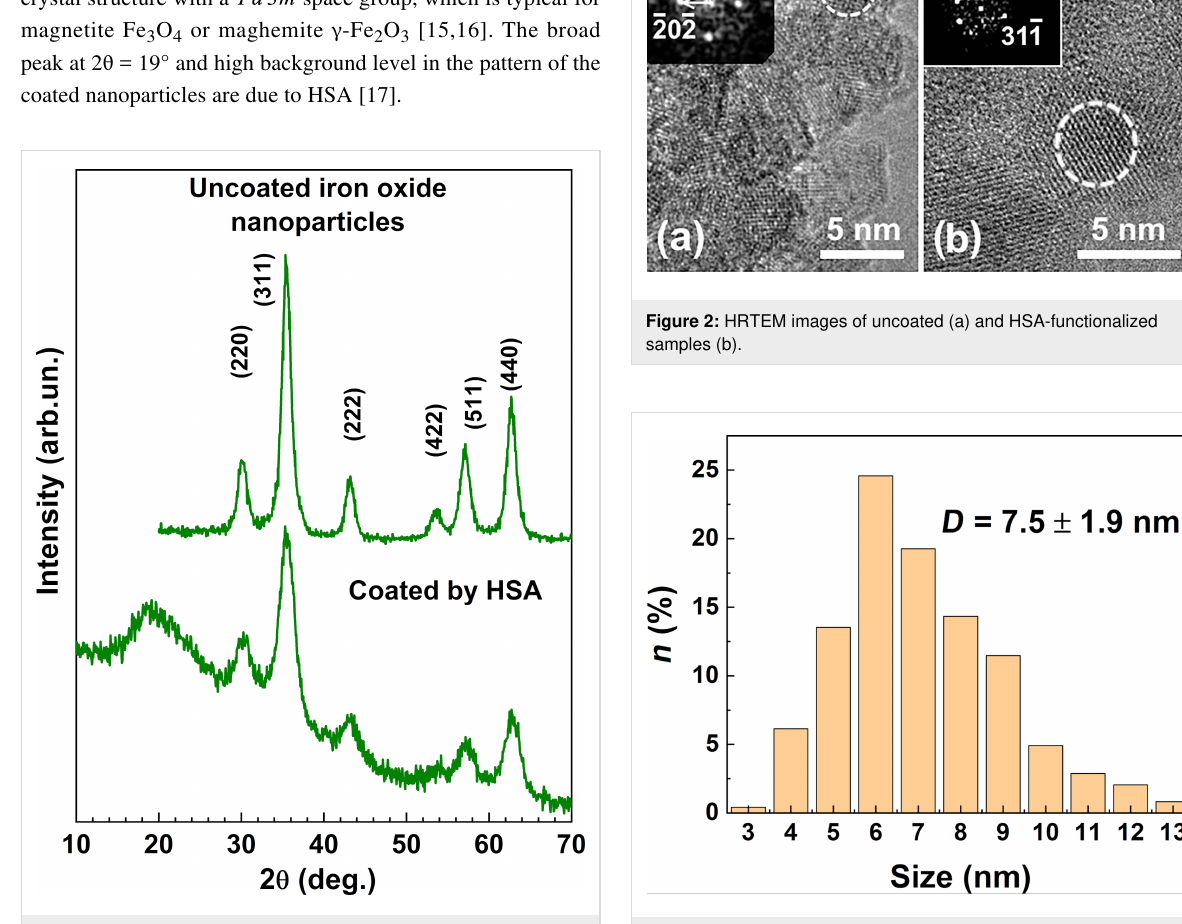
Figure 3: The particle size distribution estimated from the HRTEM images in Figure